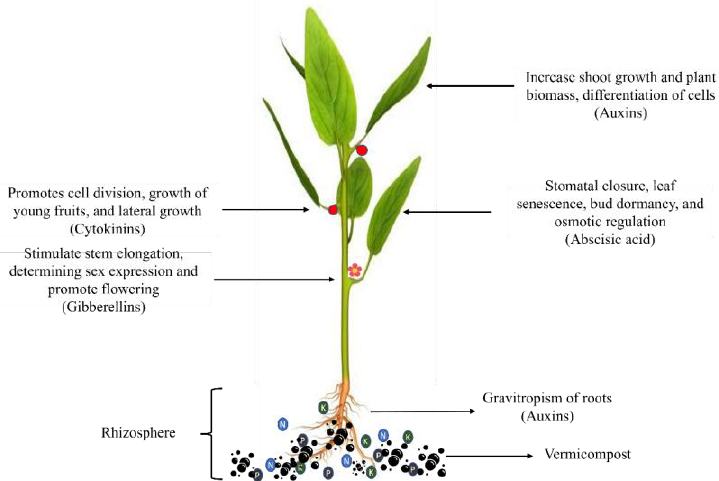
Figure 3. The physiological roles of phytohormones in plant growth and development.